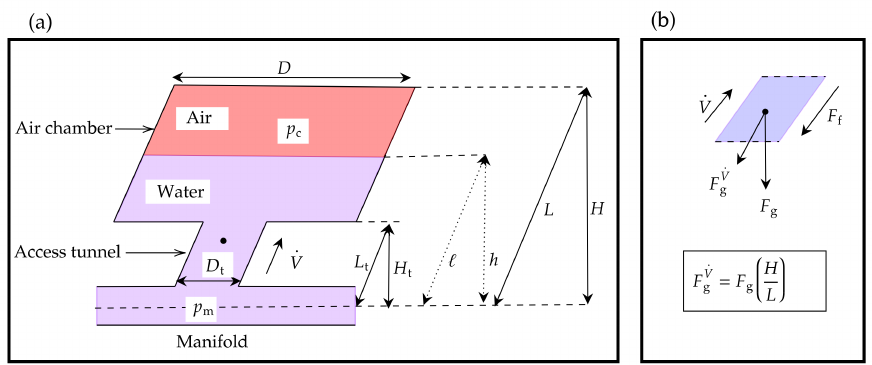
Figure 1. ACST with an access tunnel and an air chamber. ( a ) general schematic of ACST and ( b ) flow